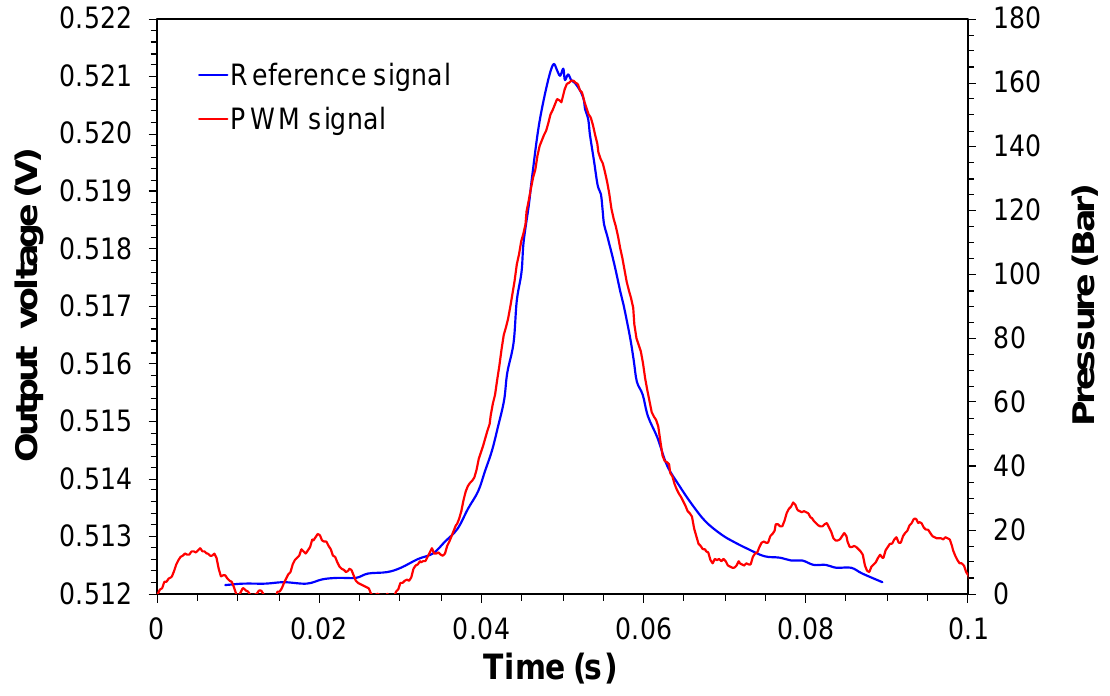
Figure 13. Dynamical curves of FBG pressure sensor in the monitoring point of engine combustion obtained by the PWM demodulator and the interrogator.